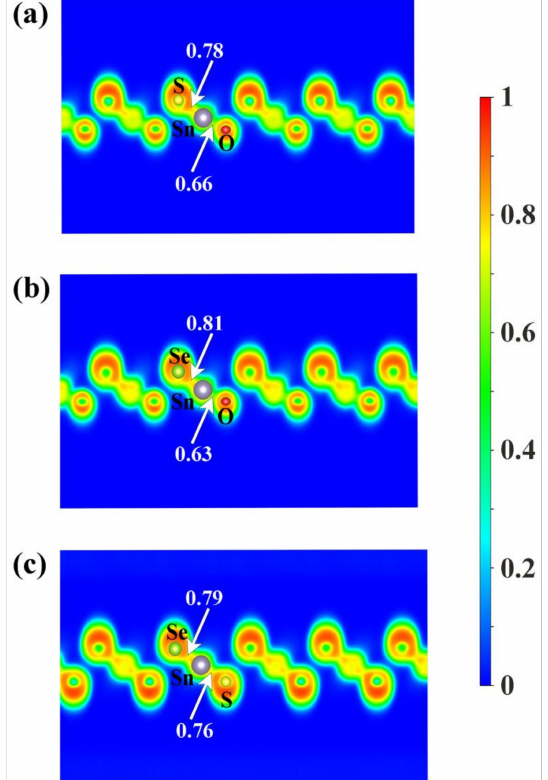
Figure 3. The electron localization function (ELF) maps sliced perpendicularly to the [110] direction for the three Janus monolayers ( a ) SnOS, ( b ) SnOSe, and ( c ) SnSSe. The numbers indicate the ELF values at the midpoints of the Sn–X and Sn–Y bonds.